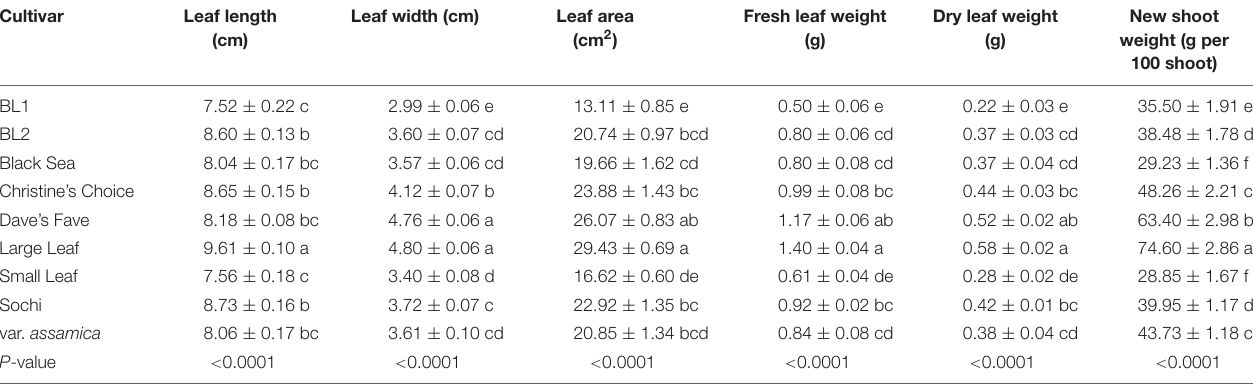
TABLE 3 | Leaf and shoot characteristics of nine tea cultivar grown in Mississippi, United States. Cultivar Leaf length Leaf width (cm) (cm)